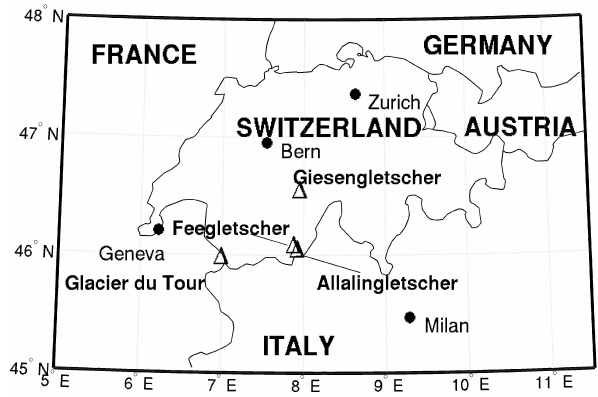
Fig. 1. General map of the location of all glaciers in this study (Allalingletscher, Feegletscher, le Glacier du Tour and